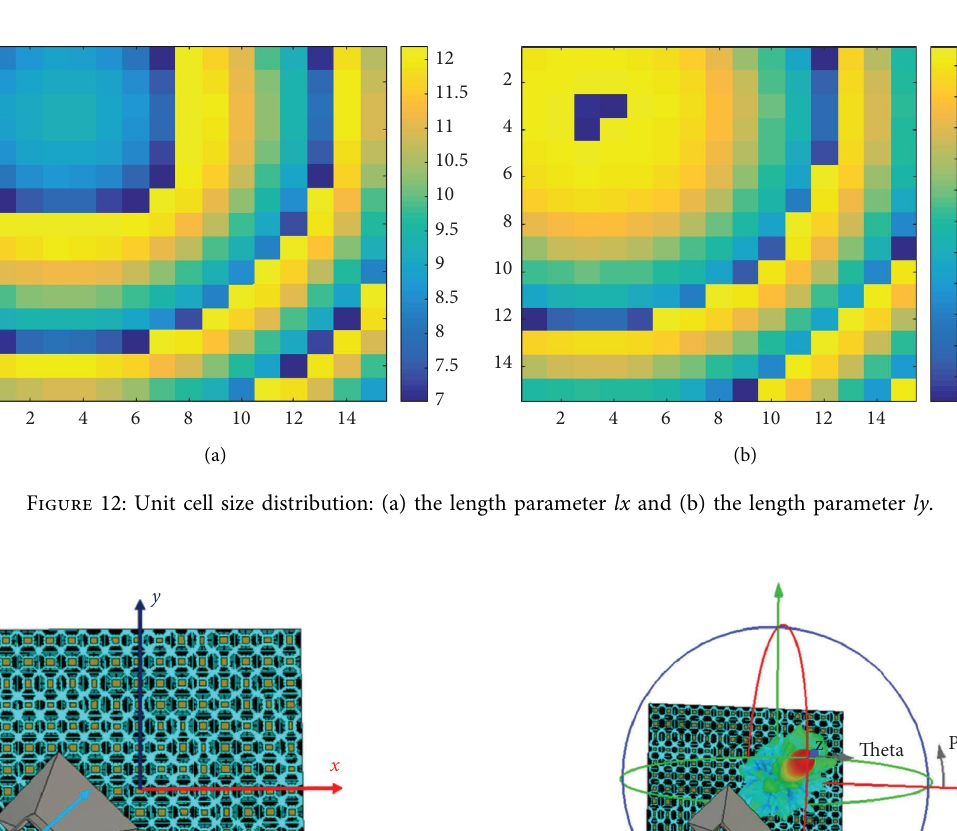
Figure 11: Unit cell phase compensation value along (a) the x -polarization direction and (b) the y -polarization direction.